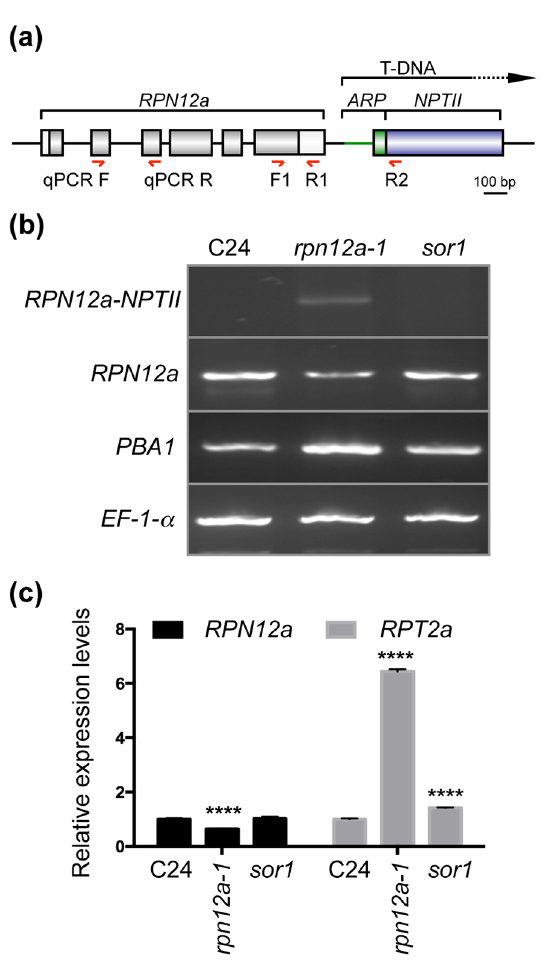
Figure 3. The sor1 mutation reduces the expression of the RPN12a‑NPTII fusion transcript. ( a ) Simplified schematic representation of the RPN12a gene and the inserted T-DNA in the rpn12a‑1 mutant 15 . The T-DNA contains the first intron and second exon of the apurinic endonuclease gene ( ARP ) fused in frame to the neomycin phosphotransferase II ( NPTII ) coding region. Exons are represented by gray boxes and introns as lines. Positions of the forward (F1) and reverse (R1 and R2) primers used for the RT-PCR and qRPN12a F and R primers used for qPCR are indicated. ( b ) Total RNA was extracted, reverse transcribed and used to amplify the RPN12a‑NPTII (42 cycles) and wild-type RPN12a transcripts (35 cycles). The primers used for the reaction are indicated. Proteasome β subunit 1 ( PBA1 ) elongation factor 1- α ( EF‑1‑ α ) are controls. ( c ) Quantitative real-time RT-PCR analyses of RPN12a and RPT2a levels in C24, rpn12a‑1 and sor1 seedlings. The reference gene was ACT2 . The transcript levels in C24 were assigned the value of 1. The data represent average relative quantity (RQ) values of three replicates, and the bars denote the RQMin to RQMax. The difference in transcript levels between C24 and the mutants is marked (****, P < 0.0001; ANOVA with Bonferroni multiple comparison Immunoblotting analyses using anti‑RPN12a antibodies showed that the sor1 mutant does not accumulate the RPN12a‑NPTII fusion protein (Figure 4). The RPN12a abundance in sor1 was increased compared to rpn12a‑1 and similar to the wild‑type. We were also unable to detect the RPN12a‑NPTII fusion in sor1 by using